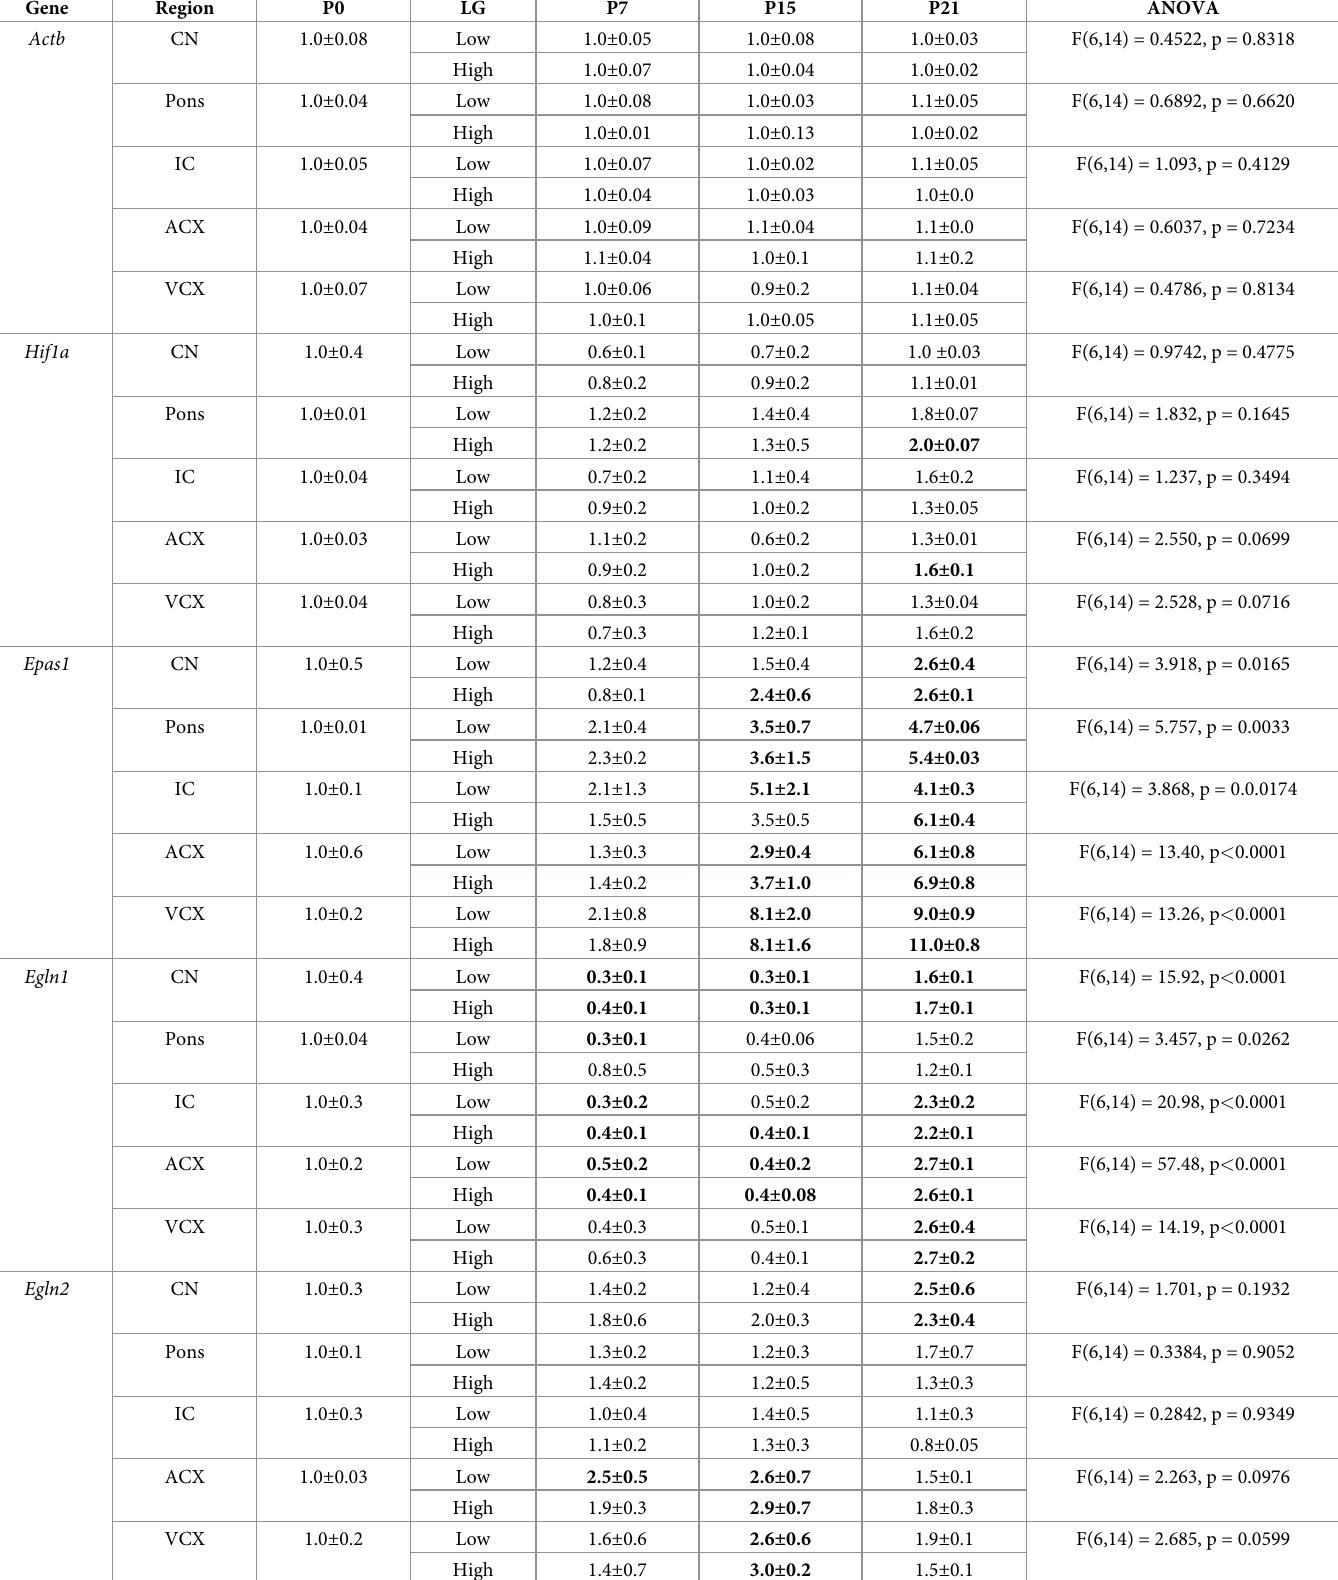
Table 4. Fold-change in brain region expression of the housekeeping gene Actb and of genes involved in the hypoxia-sensitive pathway and neurotrophin signaling. Gene Region P0 LG P7 P15 P21 ANOVA